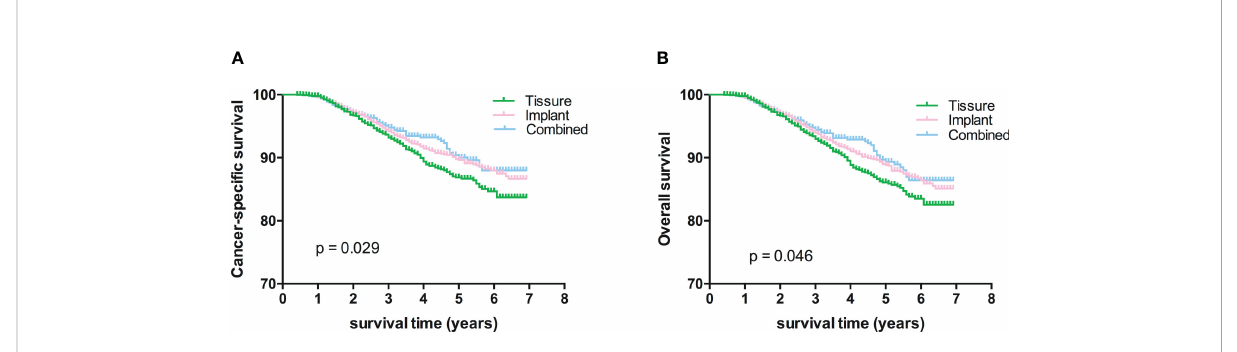
FIGURE 1 Kaplan-Meier analyses of CSS (A) and OS (B) among patients strati fi ed according to reconstructive